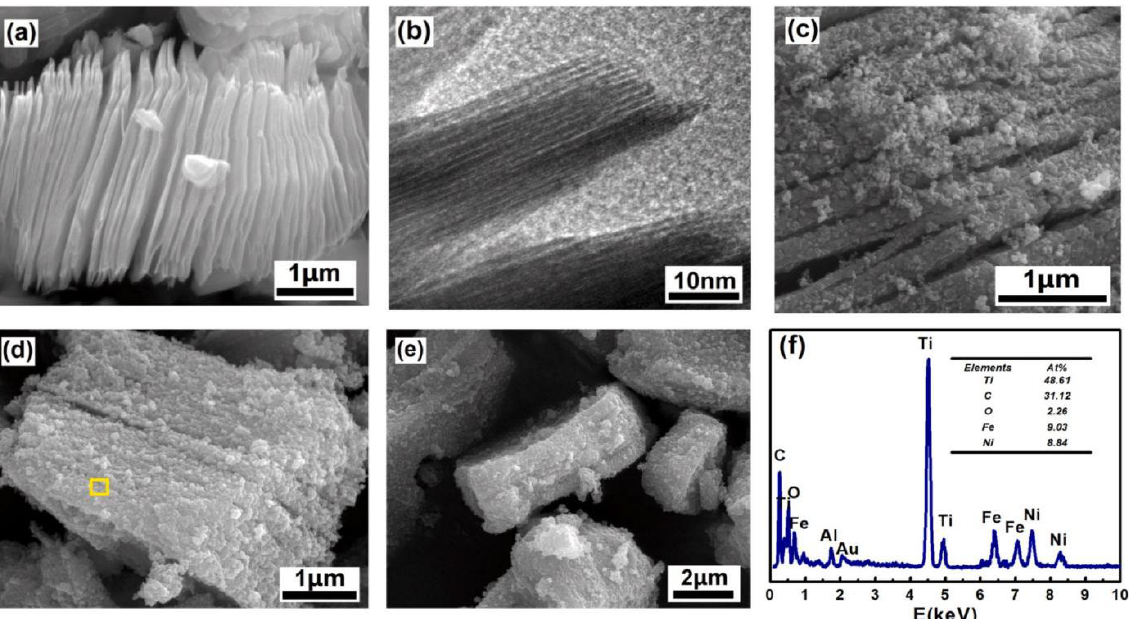
Figure 29. ( a ) SEM and ( b ) corresponding HRTEM images of Ti 3 C 2 T x MXene; SEM images of ( c ) FeNi/Ti 3 C 2 T x MXene-1, ( d ) FeNi/Ti 3 C 2 T x MXene-2 and ( e ) FeNi/Ti 3 C 2 T x MXene-3samples; ( f ) EDS spectrum of FeNi/Ti 3 C 2 T x MXene-2